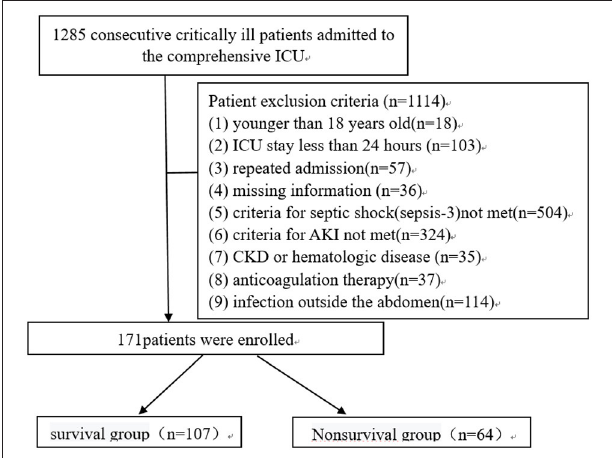
FIGURE 1 | Flowchart of the studied